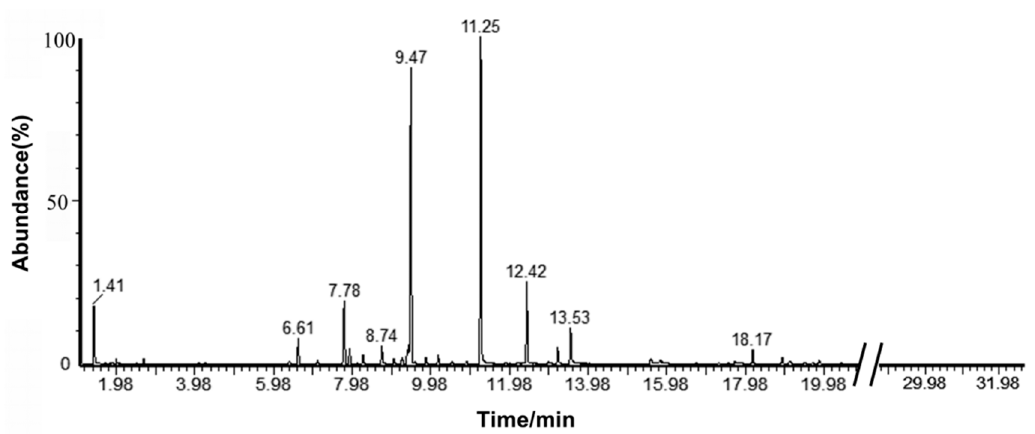
Figure 1. The GC-MS total ion chromatogram of C. camphora EO. Table 1. Chemical composition of C. camphora EO .